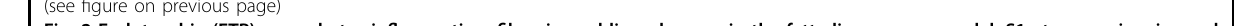
Fig. 2 Endotrophin (ETP) exacerbates in fl ammation, fi brosis, and liver damage in the fatty liver mouse model, S1a transgenic mice and insulin-resistant phenotypes. a Mass of the liver normalized to the total body weight of the mice. b , c qPCR analysis of markers of fi brosis and in fl ammation in the livers. d Masson ’ s trichrome staining and immunostaining for alpha-SMC and the macrophage marker F4/80 in livers. Bars: 150 µm. e 4-Hydroxyproline levels in livers. f – k Liver function tests in mice. * p < 0.05 vs. the livers of the Ctrl mice. ** p < 0.05 vs. the livers of the S1a/ Ctrl mice (Ctrl, n = 3; Alb-ETP, n = 9; S1a/Ctrl, n = 4; S1a/ETP, n = 5). l Serum nonesteri fi ed free fatty acid (NEFA) levels. m Serum total cholesterol (Chol) level. n Serum fasting insulin levels. o – r Blood glucose levels were measured during an oral glucose tolerance test (OGTT) or insulin tolerance test (ITT) for o , q Ctrl vs. Alb-ETP and p , r S1a/Ctrl vs. S1a/ETP. * p < 0.05 vs. the blood glucose level of either the Ctrl or S1a/Ctrl mice. (Ctrl, n = 3; Alb-